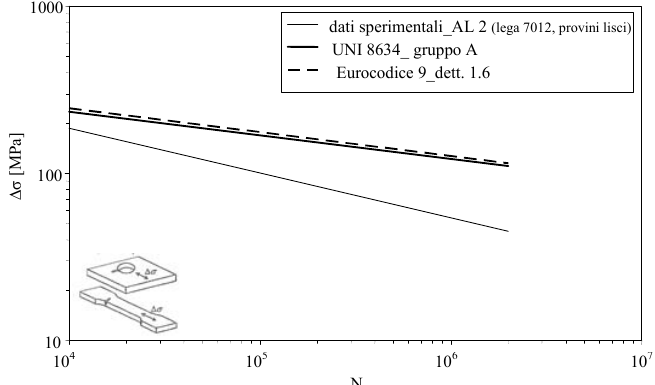
Figura 6: Confronto tra curva di resistenza a fatica per materiale base in lega 7012 (provini lisci).